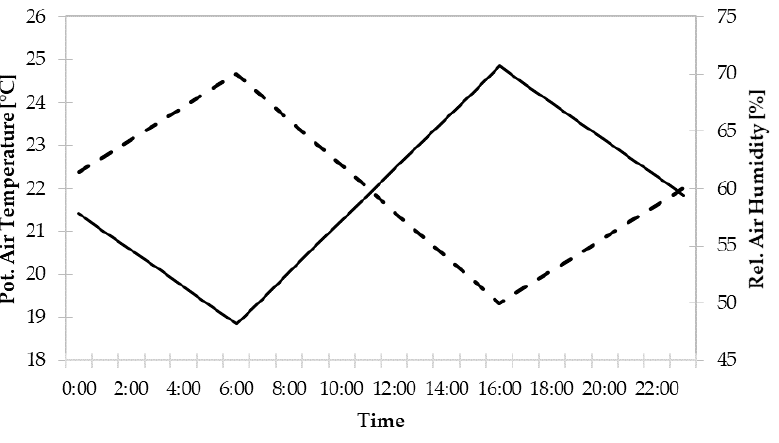
Figure 1. Diurnal boundary conditions for potential air temperature (solid line) and relative humidity (dashed line). Table 1. Simulated particles and simulation duration per examined scenario. Time Simulated Particles Simulation Time